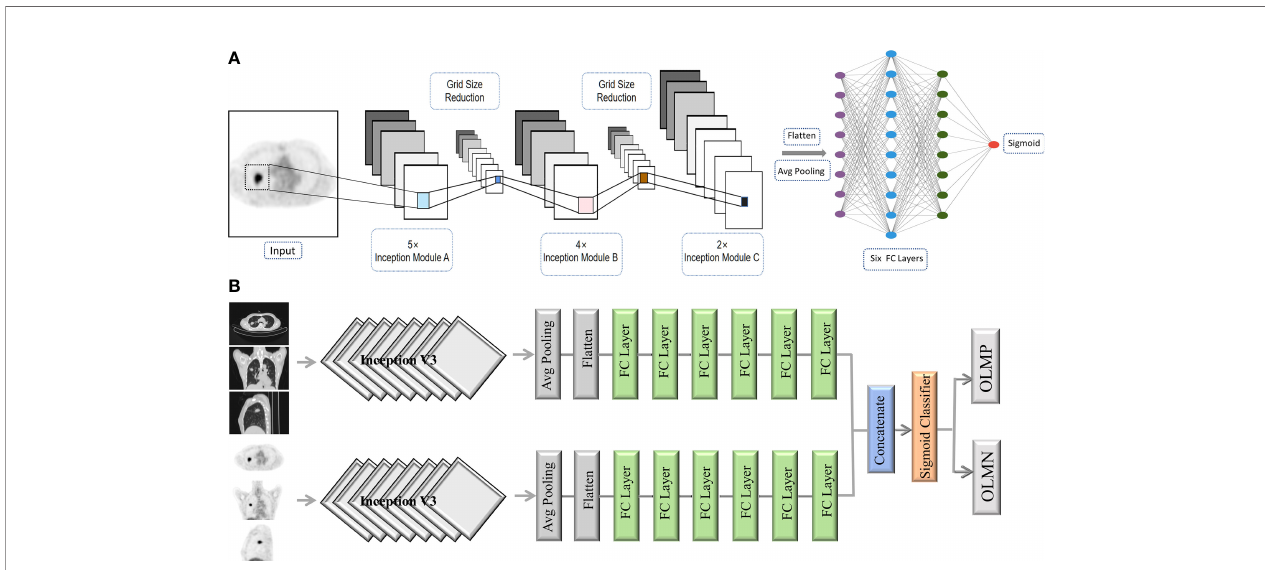
FIGURE 2 | The architecture of the CNN (A) . Schematic overview of the combined model (PET + CT) (B) . Avg pooling, average pooling; FC layer, fully connected layer; OLMN, occult lymph node metastasis negative; OLMP, occult lymph node metastasis